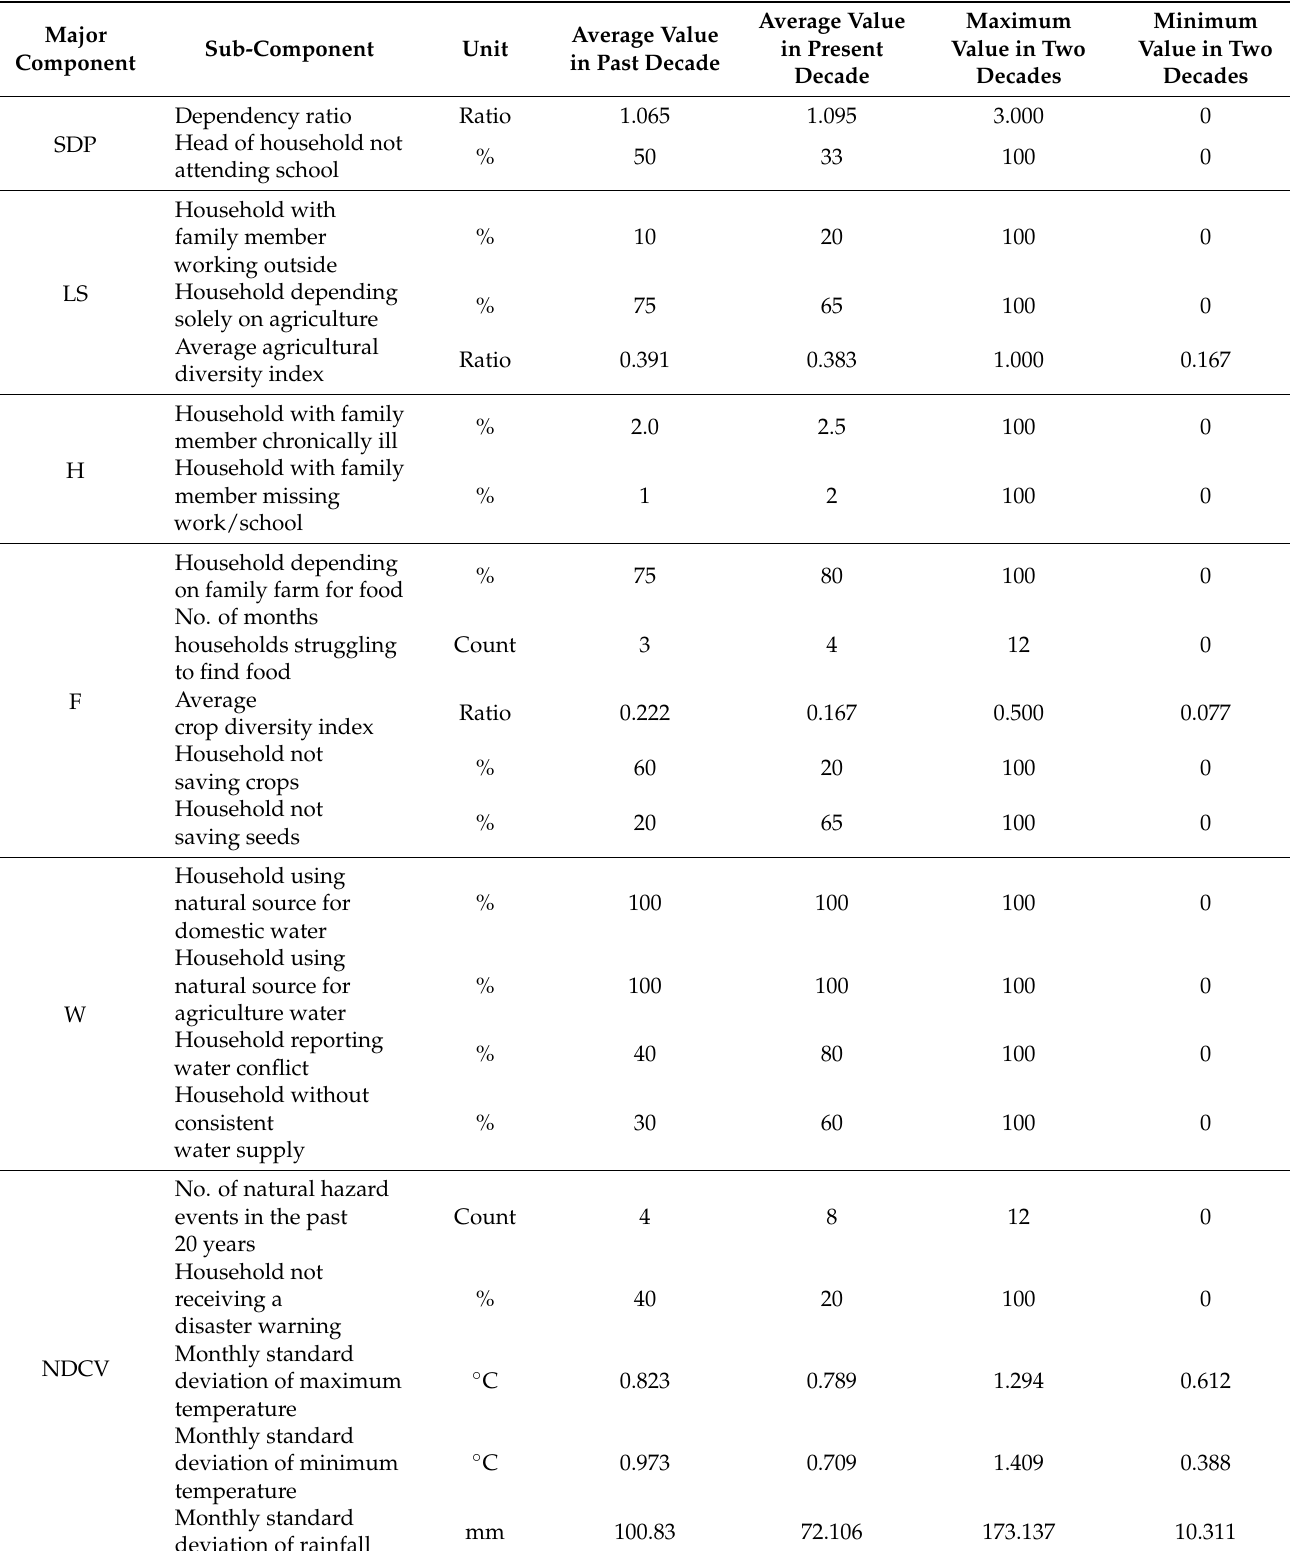
Table 6. LVI sub-component values and minimum and maximum sub-component values for the past and present decades in Polder